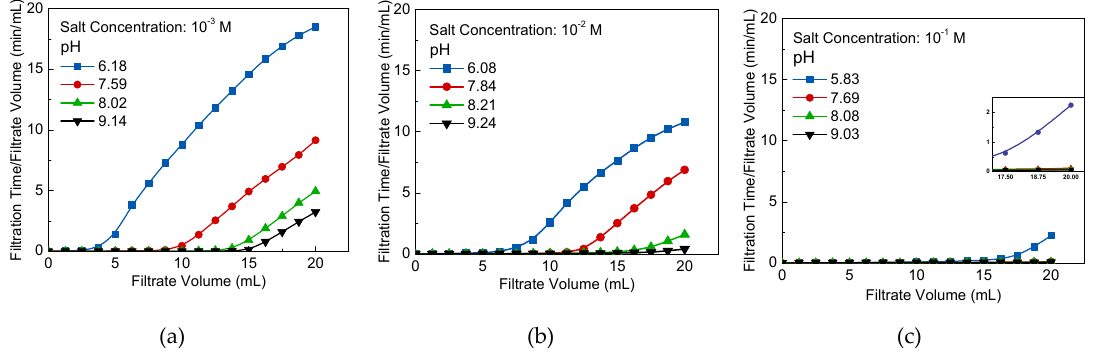
Figure 10. Darcy plot for the filtration of Na-Mt suspensions with respect to different pHs as a function of salt concentration: ( a ) 10 − 3 M; ( b ) 10 − 2 M; ( c )10 − 1 M.